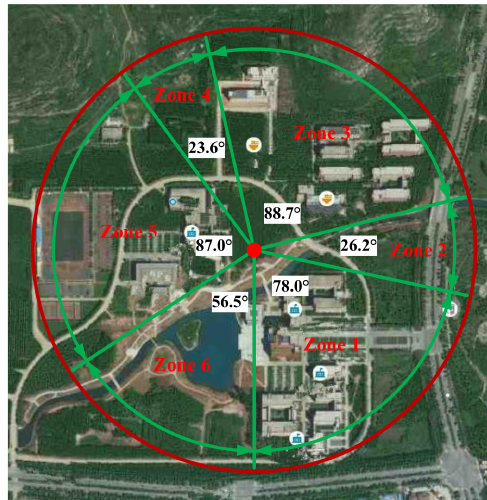
Figure 5. Partition of operation area. Table 2. Percentage of different types of areas and central angles. Zone